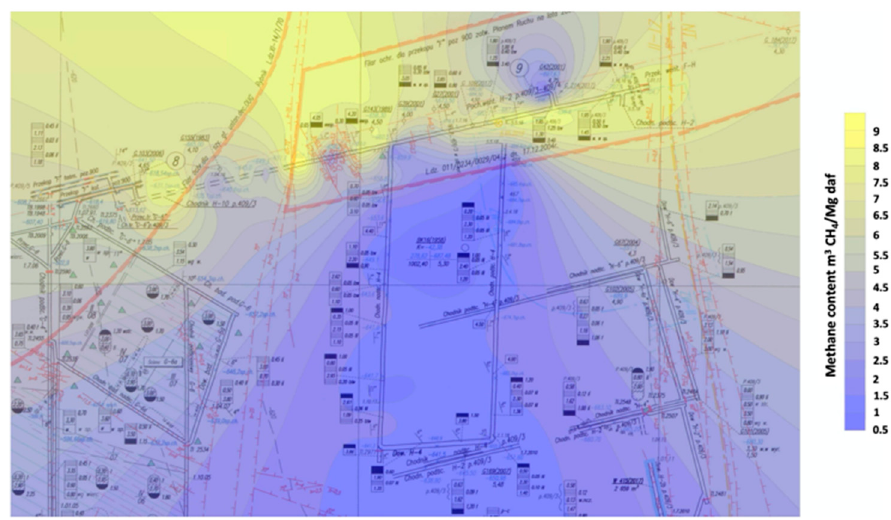
Figure 7. Isolines of methane content in the area of longwall H-4 in seam 409/4 [3].